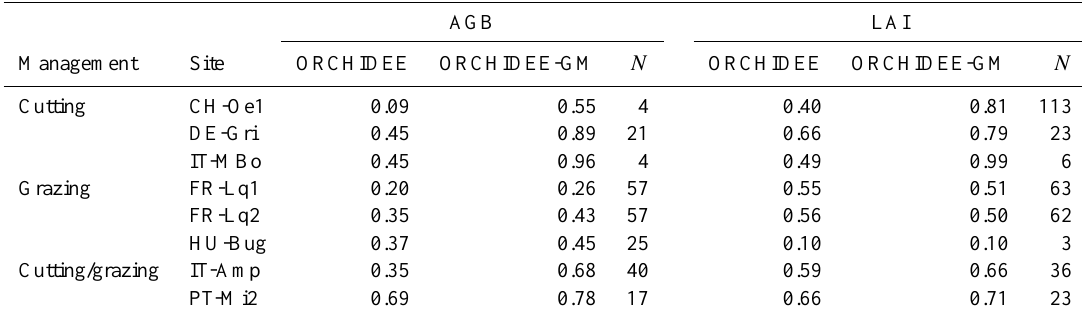
Table 3. Index of agreement (IOA) for AGB and LAI between observation and simulation by ORCHIDEE, ORCHIDEE-GM at managed grassland sites in Europe. N : number of observations.